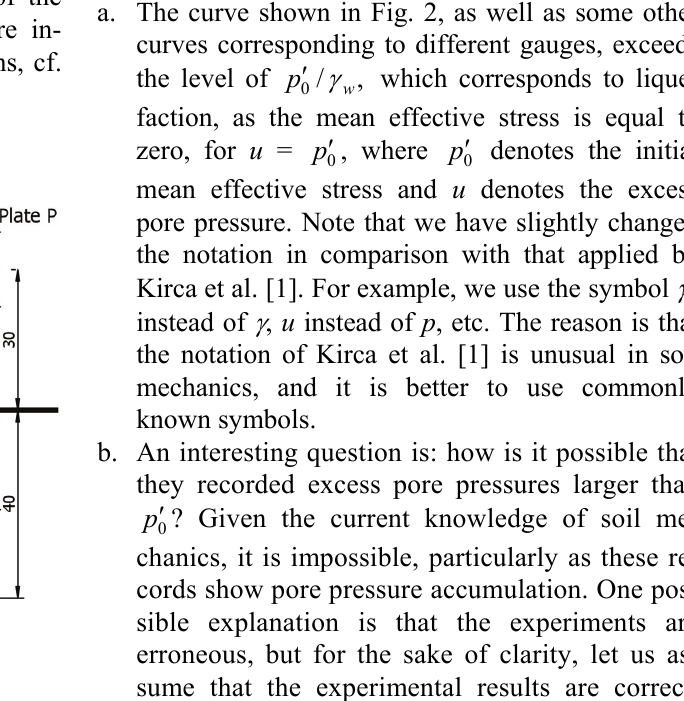
Fig. 1. Experimental set-up